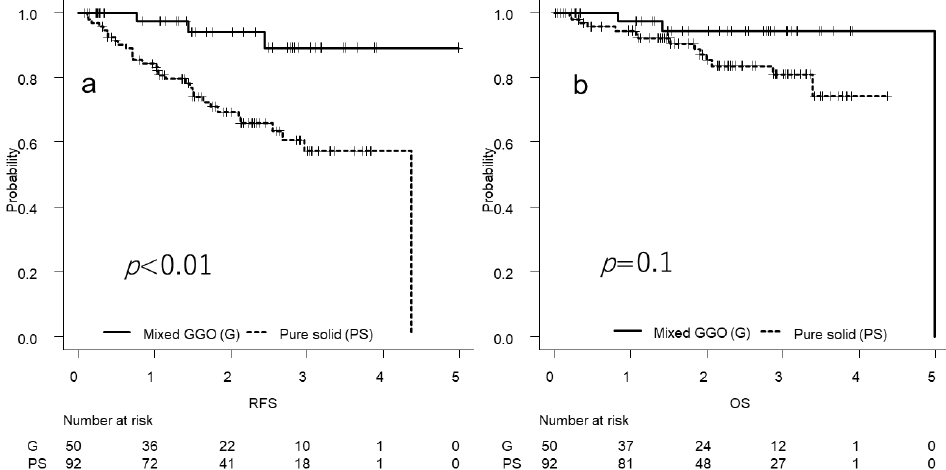
Figure 3. Survival curves according to the status of solid patterns on computed tomography. ( a ) The two-year recurrence-free survival (RFS) rate is 94.1% in the mixed GGO (G) group ( n = 50) and 69.4% in the pure solid (PS) group ( n = 92) ( p < 0.01); ( b ) the two-year overall survival (OS) rate is 94.3% in the G group and 85.4% in the PS group ( p = 0.1). Table 4. Cox proportional hazard model analyses.